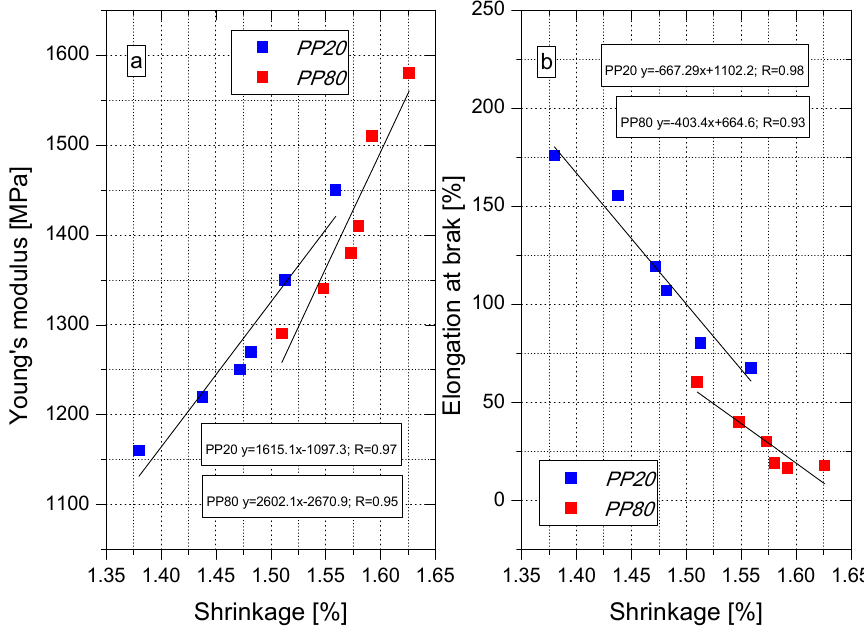
Figure 9. Correlation between young’s modulus ( a ), elongation ( b ) at break and shrinkage. Annealing of the conditioned PP20 and PP80 samples for 24 h at 140 ◦ C resulted in an increase in the value of the modulus of elasticity (Table 4). Moreover, the difference between E values of the samples processed under different conditions decreased. The determined values were equal to 1650 MPa (PP20) and 1710 MPa (PP80), respectively. The annealed PP20 and PP80 samples were also characterized by similar values of tensile strength (35 MPa) and elongation at break (20%). However, in the case of PP20 samples, annealing resulted in an increase in the maximum stress, while for PP80, its decrease was recorded. The similar values of mechanical properties determined during the static tensile test of two series of samples are convergent with the results of shrinkage and the degree of crystallinity tests. Moreover, annealing resulted in a significant increase in the impact strength of the samples in comparison with the values recorded after 504 h of condition- ing. In the case of PP20, the determined value was equal to 220 kJ/m 2 , while for PP80, it was 90.8 kJ/m 2 . The Charpy impact strength values confirm the upward tendency of this parameter value observed for the samples conditioned for 504 h. The observed increase in the impact strength of PP samples after annealing is caused by the changes in the mor- phology of the material’s crystalline structure, which are difficult to be clearly assessed on the basis of the conducted tests results obtained with the use of the differential scanning calorimetry method. Changes in the morphology of the crystalline structure may, for ex- ample, involve the transition of the α -PP phase to the β - PP phase, which is characterized by a higher impact strength value [13,15].